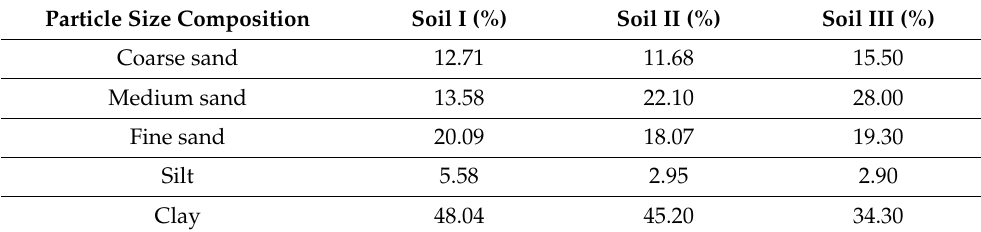
Table 2. Soil particle size.